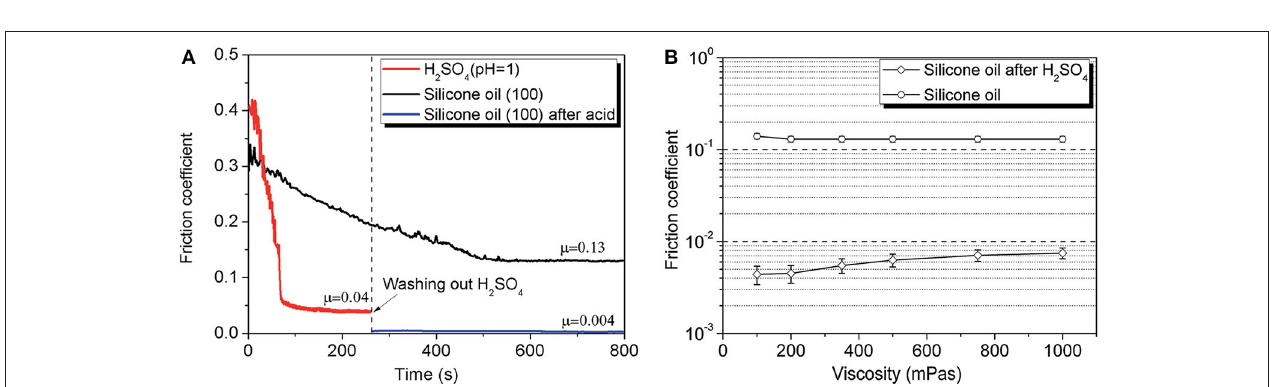
FIGURE 12 | (A) COF under lubrication with 100 mPa · s silicone oil, H 2 SO 4 (pH = 1), and 100 mPa · s silicone oil after wearing-in with H 2 SO 4 (pH = 1). (B) Final COF of silicone oils between the original surfaces (Si 3 N 4 /glass) and the surfaces after wearing-in with H 2 SO 4 (pH = 1). The error bars represent the standard deviations of five measured values. Li et al. (2015a) Copyright 2015, the Royal Society of